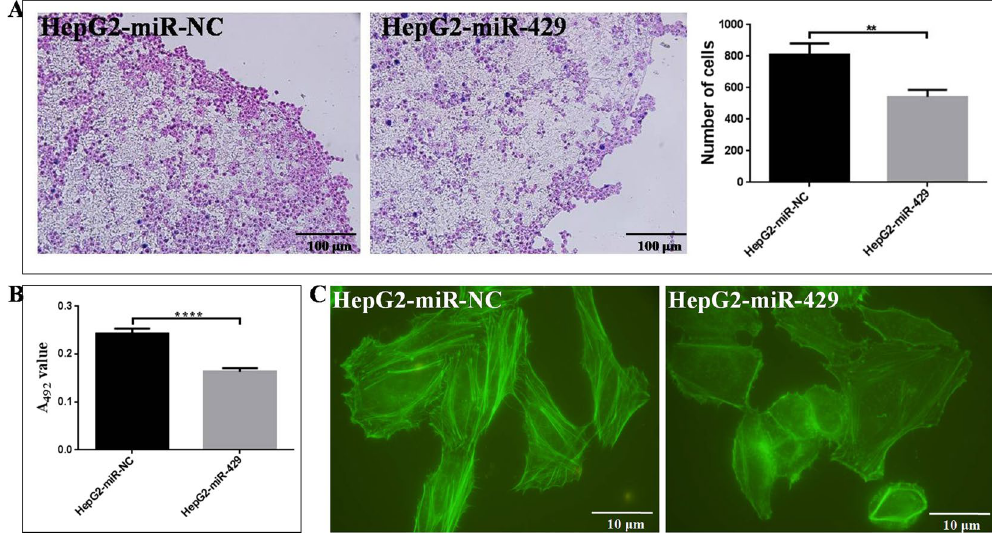
Figure 4. The effect of miR-429 overexpression on the cell adhesion ability and F-actin cytoskeleton expression and arrangement of HepG2. ( A ) miR-429 overexpression inhibited the in situ LN adhesion capacity of HepG2 ( ** P < 0.01). ( B ) miR-429 overexpression inhibited the extracellular matrix adhesion ability of HepG2 to FN by MTT assay ( **** refers to P value of the difference < 0.0001 than control). ( C ) miR-429 overexpression suppressed the expression and destructed the arrangement of F-actin in HepG2 cytoskeleton by FITC- phalloidin